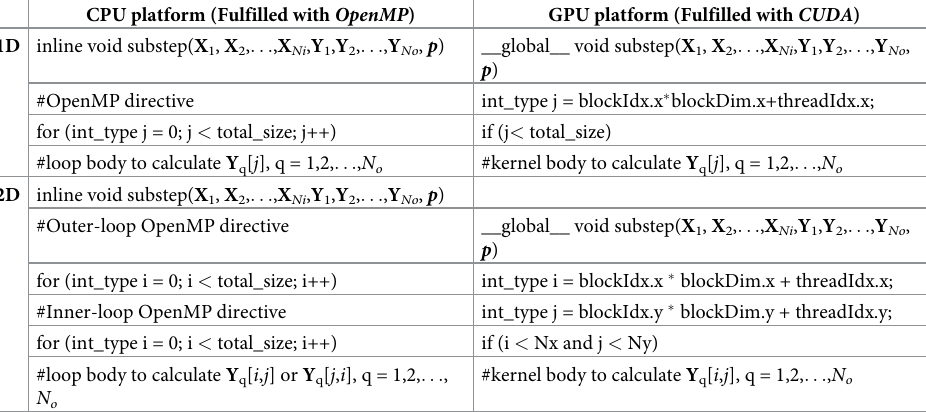
Table 5. Pseudocodes for the operations. CPU platform (Fulfilled with OpenMP ) GPU platform (Fulfilled with CUDA